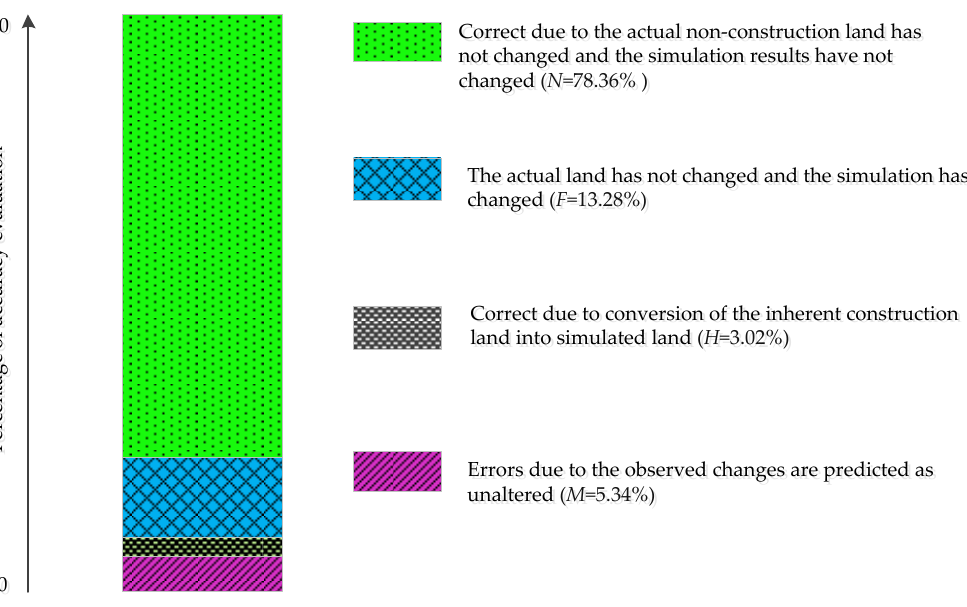
Figure 10. At a 30-by-30 m fine resolution, the overall landscape of the overall prediction of success Figure10. At 30-by-30 meters fine resolution, the overall landscape of the overall prediction and of success and error.